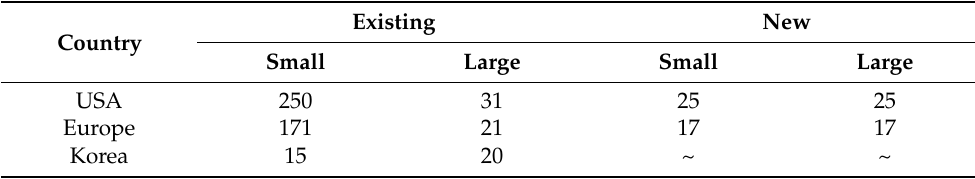
Table 2. HCl emission limit (ppmv) for municipal solid waste incinerators [8–10]. Country